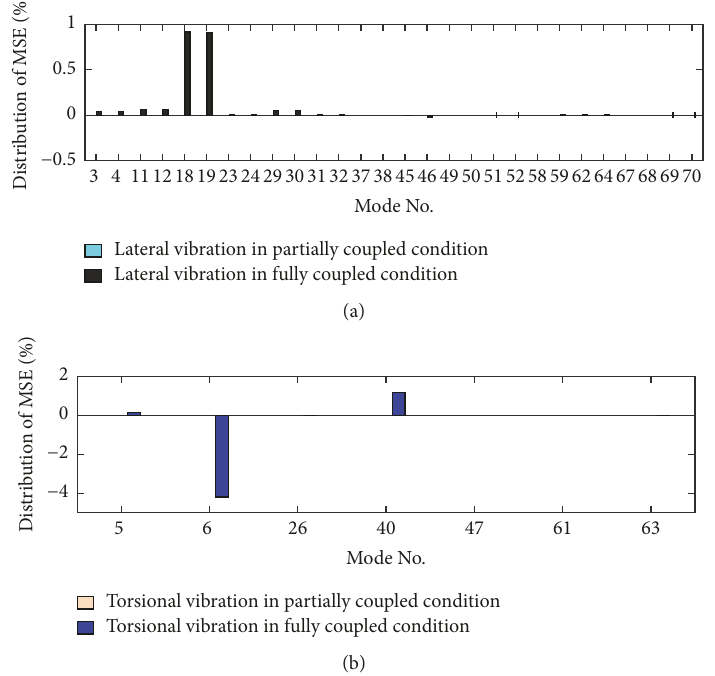
Figure 11: Relative deviation of the natural frequencies dominated by the input rotor subsystem.